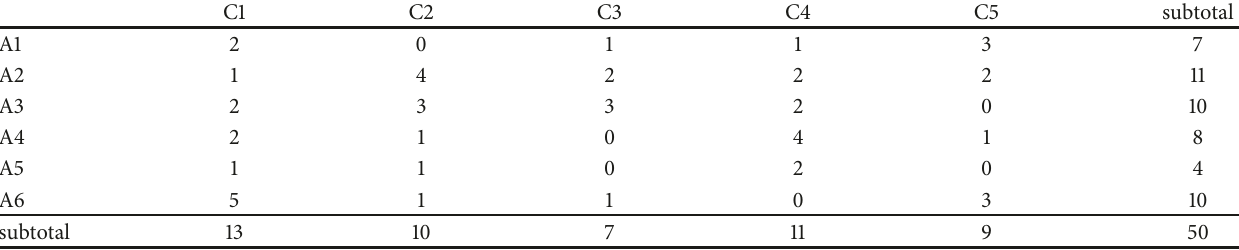
Table 2: Country A’s installed air force.